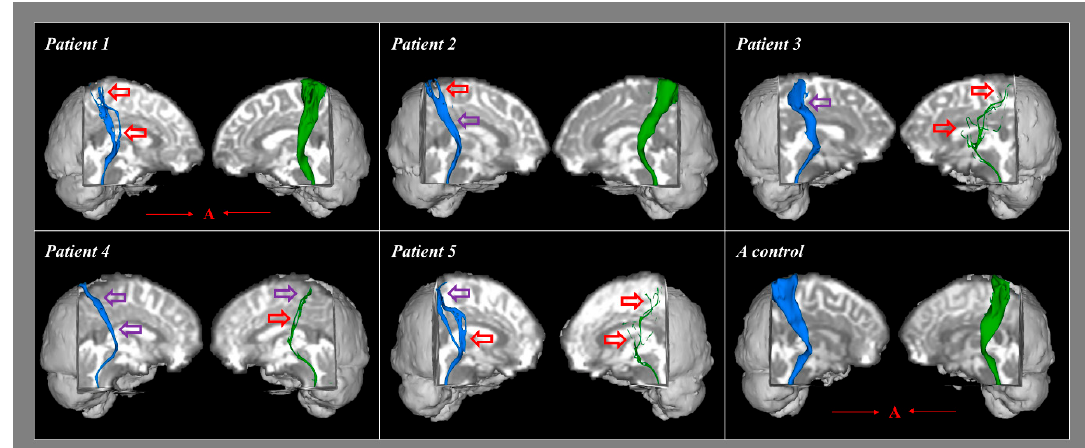
Figure 1. Results of diffusion tensor tractography (DTT) for the spinothalamic tract of five patients and a representative control group subject. Partially torn and narrowed areas are marked with red arrows while narrowed areas are marked with purple arrows (blue color is right spinothalamic tract and green color is left spinothalamic tract). A (red): anterior direction.